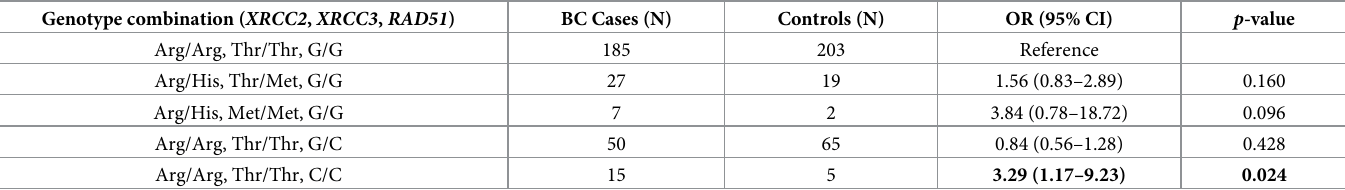
Table 5. Investigation of combinatorial impact of SNPs on BC risk. Genotype combination ( XRCC2 , XRCC3 , RAD51 )